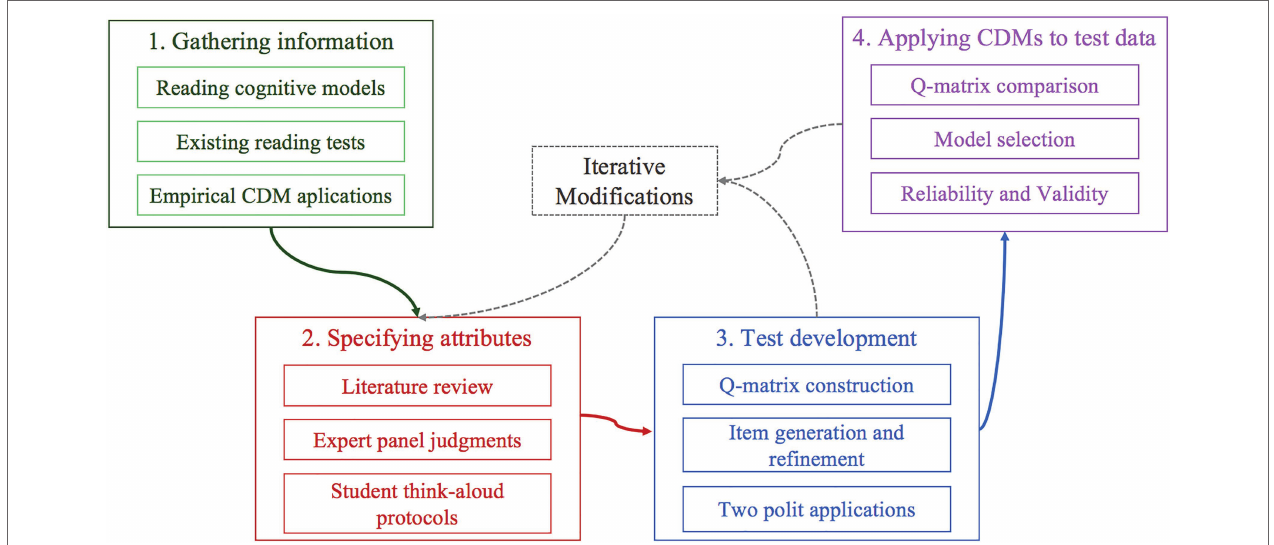
FIGURE 1 | An overview of the research